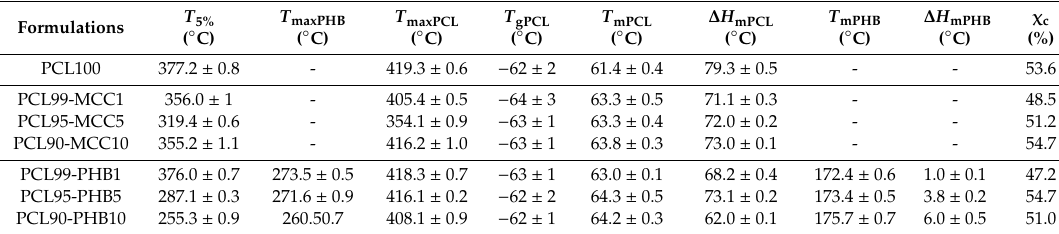
Figure 4. Thermogravimetric analysis (TGA) of electrospun PCL-MCC and PCL-PHB mats: ( a ) TGA curve of PCL-MCC, ( b ) DTG curve of PCL-MCC, ( c ) TGA curve of PCL-PHB and ( d ) DTG curve of PCL-PHB. Table 3. TGA and DSC thermal parameters of electrospun